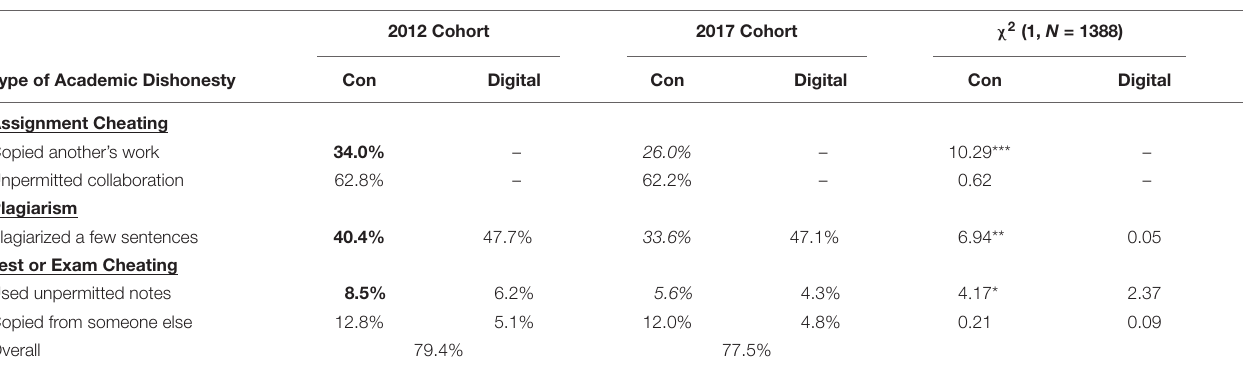
TABLE 7 | Participants self-reported engagement in academic dishonesty by